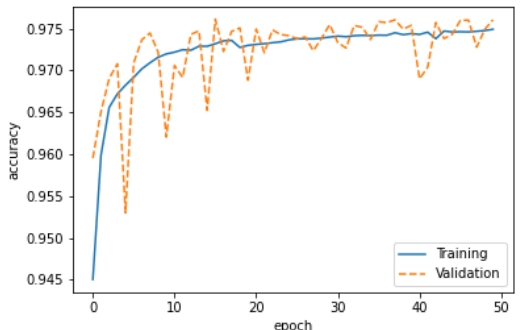
Figure 7. Training and validation accuracy.